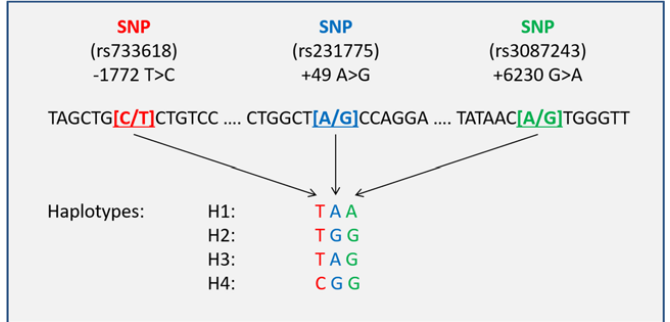
Figure 1. Compound cytotoxic T lymphocyte ‐ associated protein 4 (CTLA ‐ 4) haplotypes. SNP, single nucleotide polymorphism. Table 3. CTLA ‐ 4 haplotype distributions.